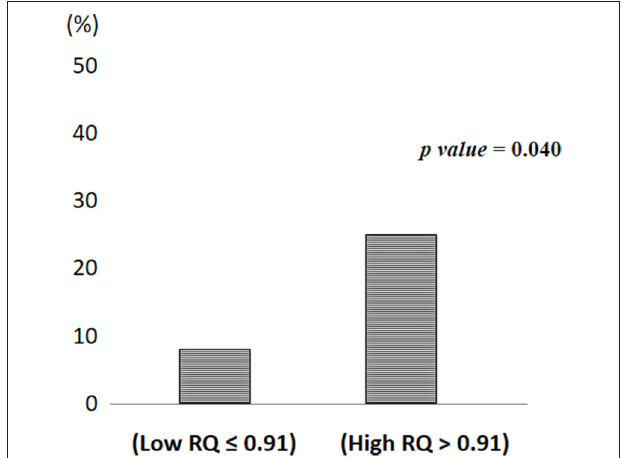
FIGURE 2 | Metabolic syndrome/Type 2 diabetes incidence according to low and high respiratory quotient.